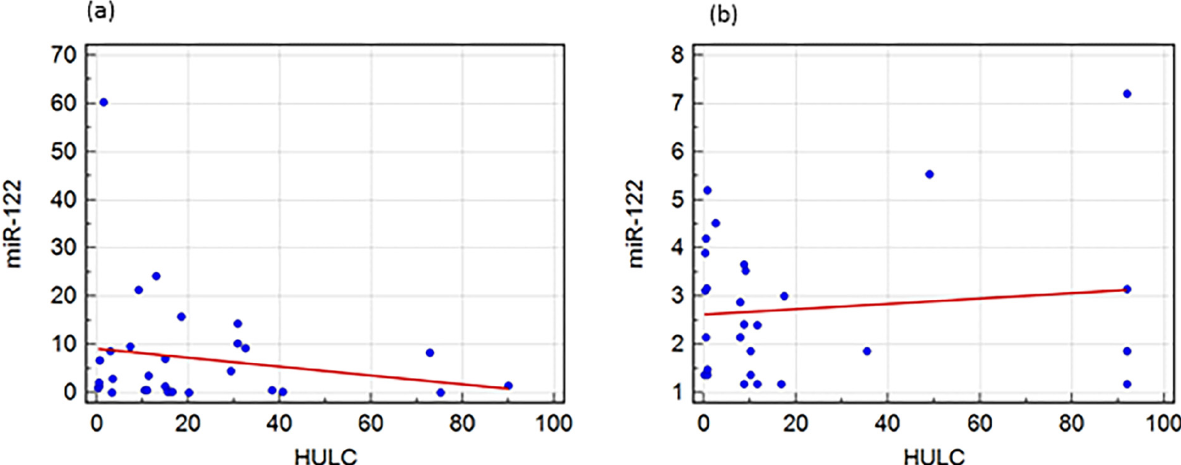
Figure 5. Logistic regression to determine the possibility of using the tested biomarkers in predicting HCV and HCC. ( a ) relationship between serum biomarkers for HCV group (unstandardized coef- ficient is − 0.115, standardized coefficient is − 0.206, p -value = 0.005) and ( b ) relationship between serum biomarkers for HCC group (unstandardized coefficient is 0.009, standardized coefficient is 0.194, p -value =